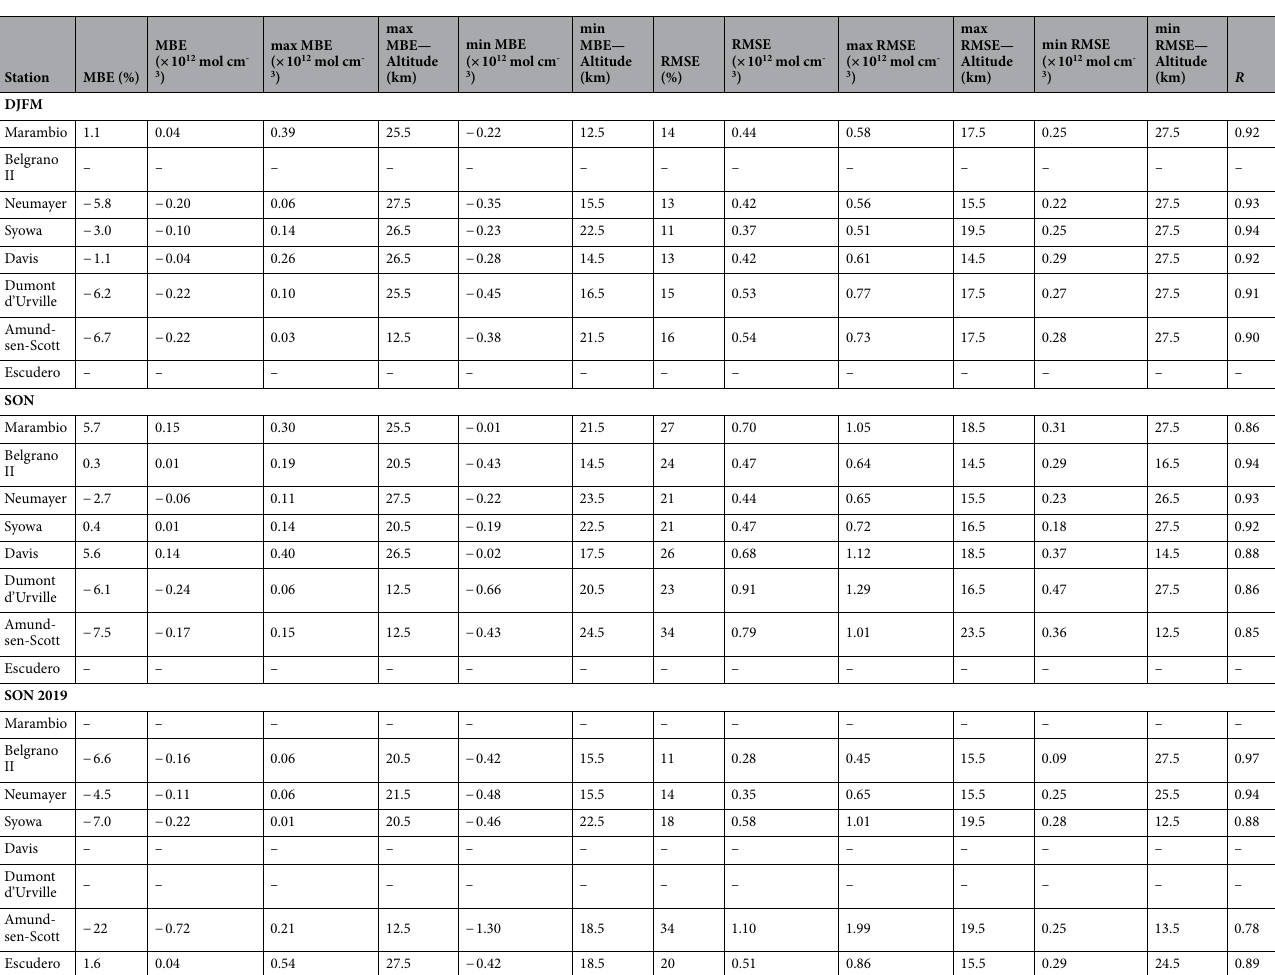
Table 2. Mean Bias Error ( MBE ) and Root Mean Square Error ( RMSE ) over the periods: DJFM 2013–2020, SON 2012–2018 and SON 2019. Maximum and minimum values of the MBE and RMSE profiles are also shown. Since few profiles were available, data are not shown for some